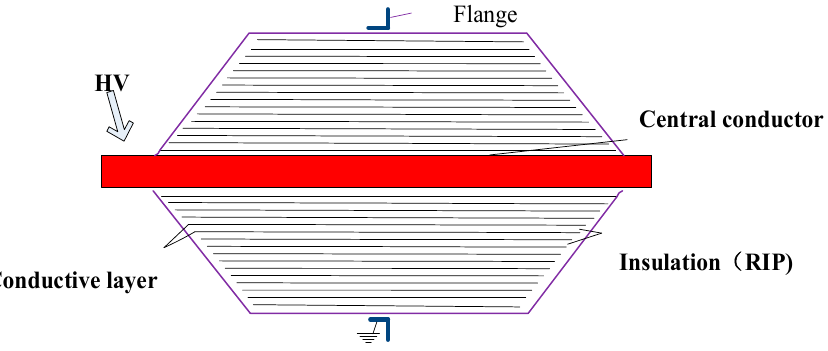
Figure 1. Schematic representation of the condenser core for dry bushing.